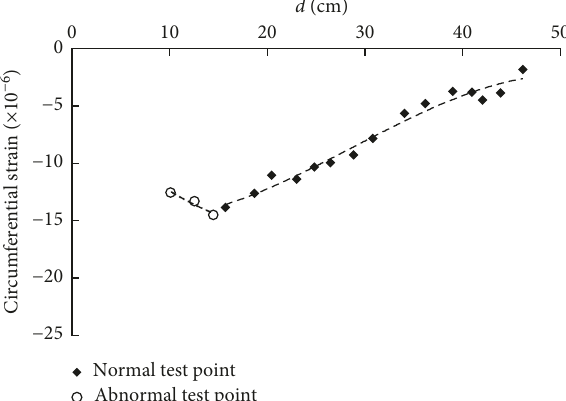
Figure 5: Loading system for test.